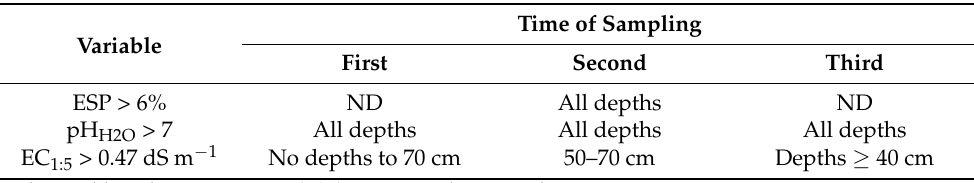
Figure 3. Effect on green leaf cover by barley of tillage ( A , C ) and amendment ( B , D ) in the 2019 growing season ( A , B ), and the 2020 season ( C , D ). Each point is the average of 16 ( A , C ) or 8 values ( B , D ). The significance of treatment comparisons is indicated at each date. Amendments were: nil, gypsum (G), elemental sulfur (ES), and gypsum plus elemental sulfur (G+ES). The soil was a Vertic Calcic Calcisol located on Merredin Research Station ( − 31 ◦ 30 (cid:48) 25 (cid:48)(cid:48) S, 118 ◦ 13 (cid:48) 04 (cid:48)(cid:48) E). Statistical significance is as follows: ns = not significant; * p < 0.05; ** p < 0.01; *** p < 0.001. Table 4. Selected properties (based on average values across all treatments) at the three times of soil sampling. The data for these samplings are given in the Supplementary Materials, Tables